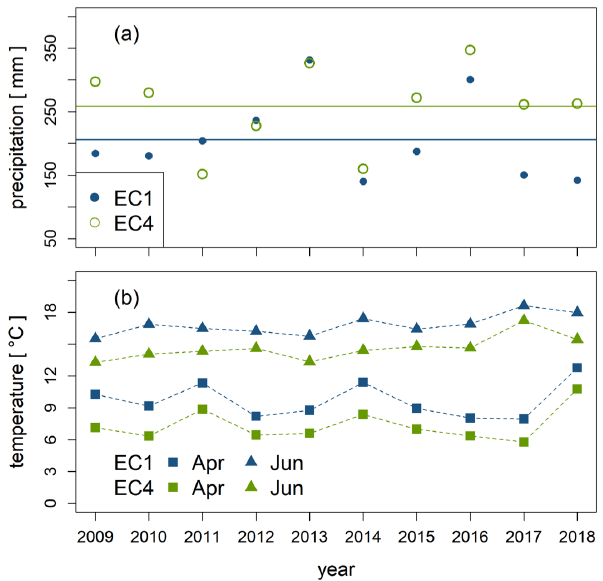
Figure 4. (a) Selected meteorological variables at EC1 and EC4. Mean cumulative April–June precipitation; lines indicate the re- spective means. The years 2014, 2015 and 2018 show very dry growing-season precipitation in KR (EC1) and in 2011 and 2014 in SA (EC4). The difference in mean precipitation is 60mm. (b) April and June mean air temperatures for 2009 to 2018. SA is 2.2 (0.5) ◦ C cooler than KR. The years 2011, 2014 and 2018 showed very warm April months. The June temperature increases gradually from 2009 to